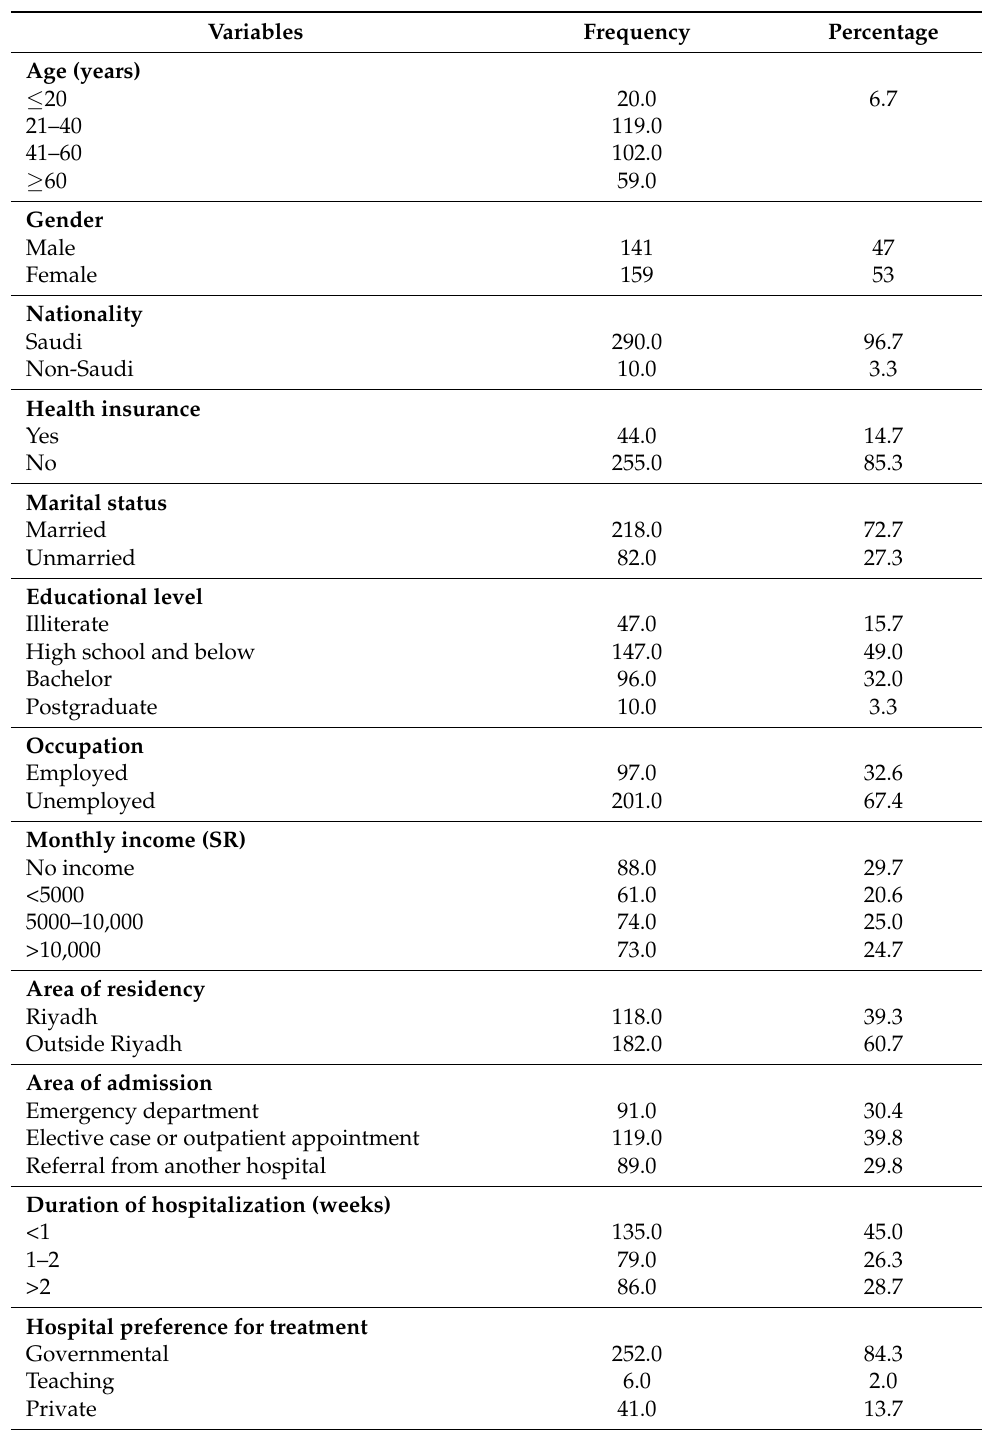
Table 1. Demographic